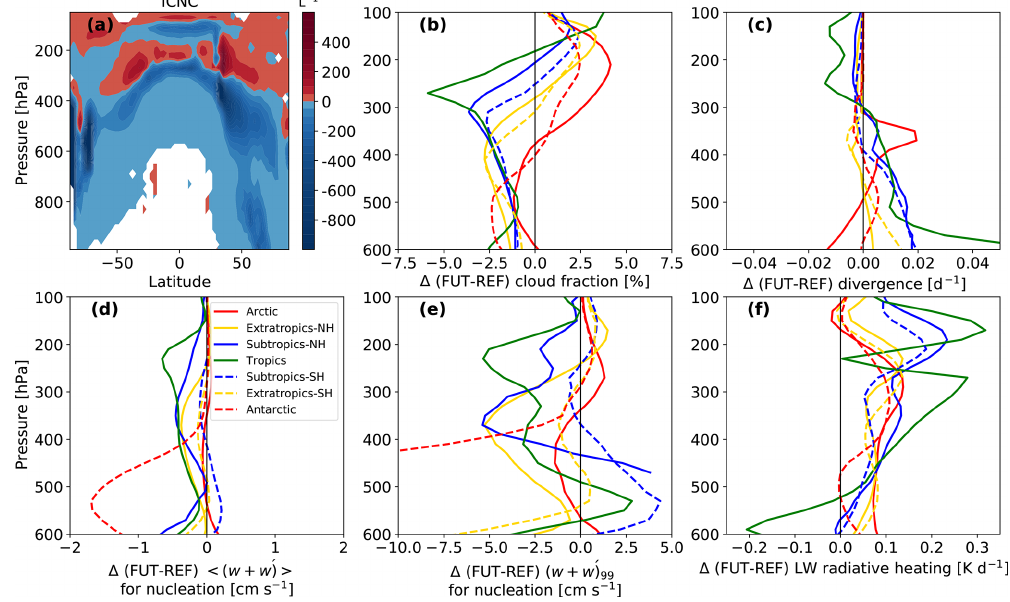
Figure 10. (a) Absolute difference in ICNC between the FUT and REF simulations. (b) FUT-REF differences in the mean cloud fraction; (c) mean divergence; (d) mean input vertical velocity to the ice nucleation scheme, grid-scale plus subgrid-scale variability term ( (cid:104) w + w (cid:48) (cid:105) ); (e) extreme input vertical velocity to the ice nucleation scheme; and (f) longwave (LW) cloud radiative heating in different zonal bands. The Arctic is defined as north of 60 ◦ N and the Antarctic as south of 60 ◦ S; the extratropics are between 40 and 60 ◦ S and N, the subtropics between 20 and 40 ◦ S and N, and the tropics between 20 ◦ S and 20 ◦